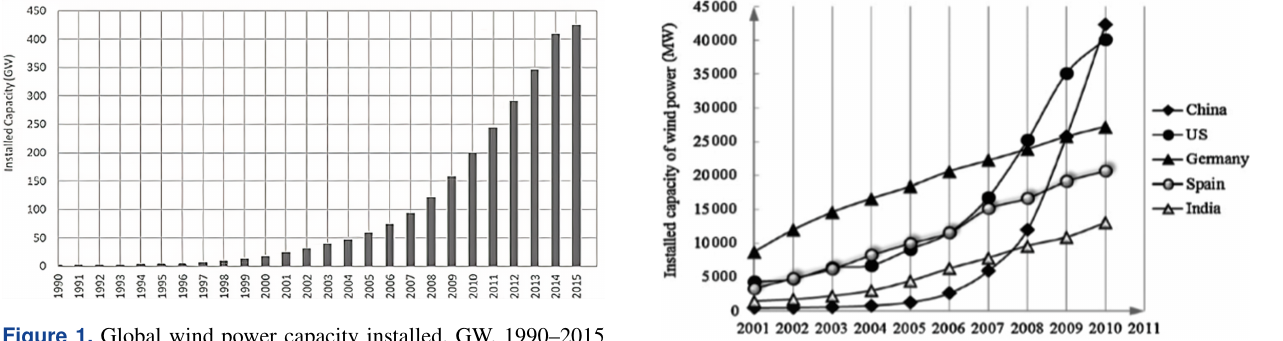
Figure 2. Installed wind power capacity in leading countries (US, PR China, Germany, India and Spain; Global Wind Energy Council,